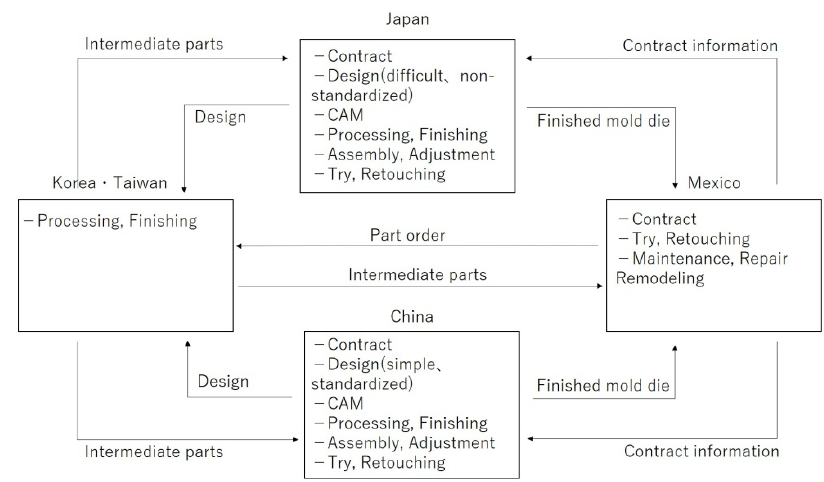
Figure 1. Structure of international value